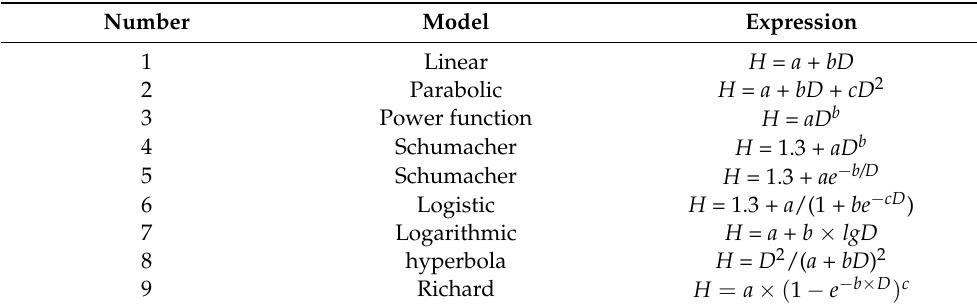
Table 2. Tree height curve models were compared in this